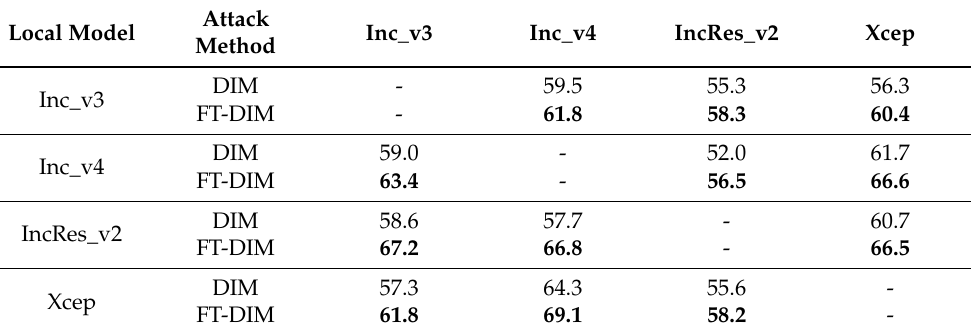
Table 4. The black-box ASRs of DIM and FT-DIM on ImageNet. The first column is the local model, and the first row is the target model. The values in the table are the ASRs (%) on the target models using the adversarial examples generated with the local models. The higher ASRs are shown in bold.